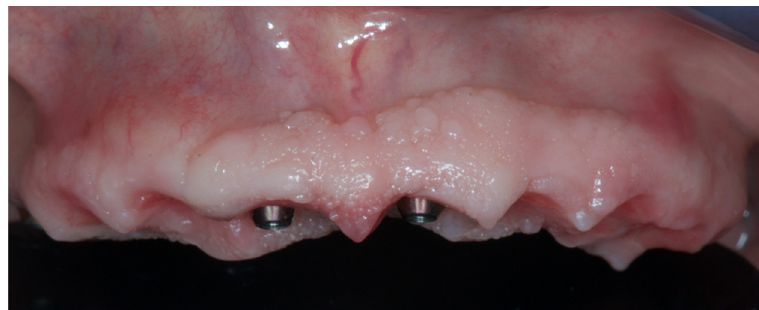
Figure 7. Soft tissue frontal view after 6 months of provisional conditioning.